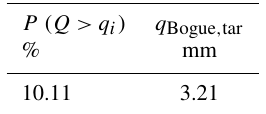
Table A4. The initially unknown streamflow value corresponding to the 10.11th percentile estimated for the target year (i.e., 1968–1969) at the target basin (i.e., Bogue River,